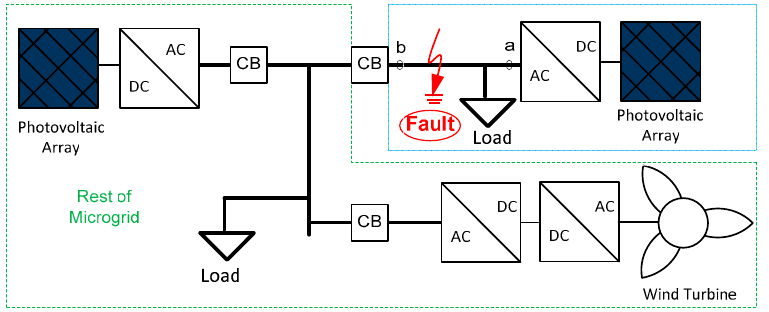
Figure 1. Inverter-based microgrid under study. CB refers to a circuit breaker. The dotted blue line represents a microgrid feeder.